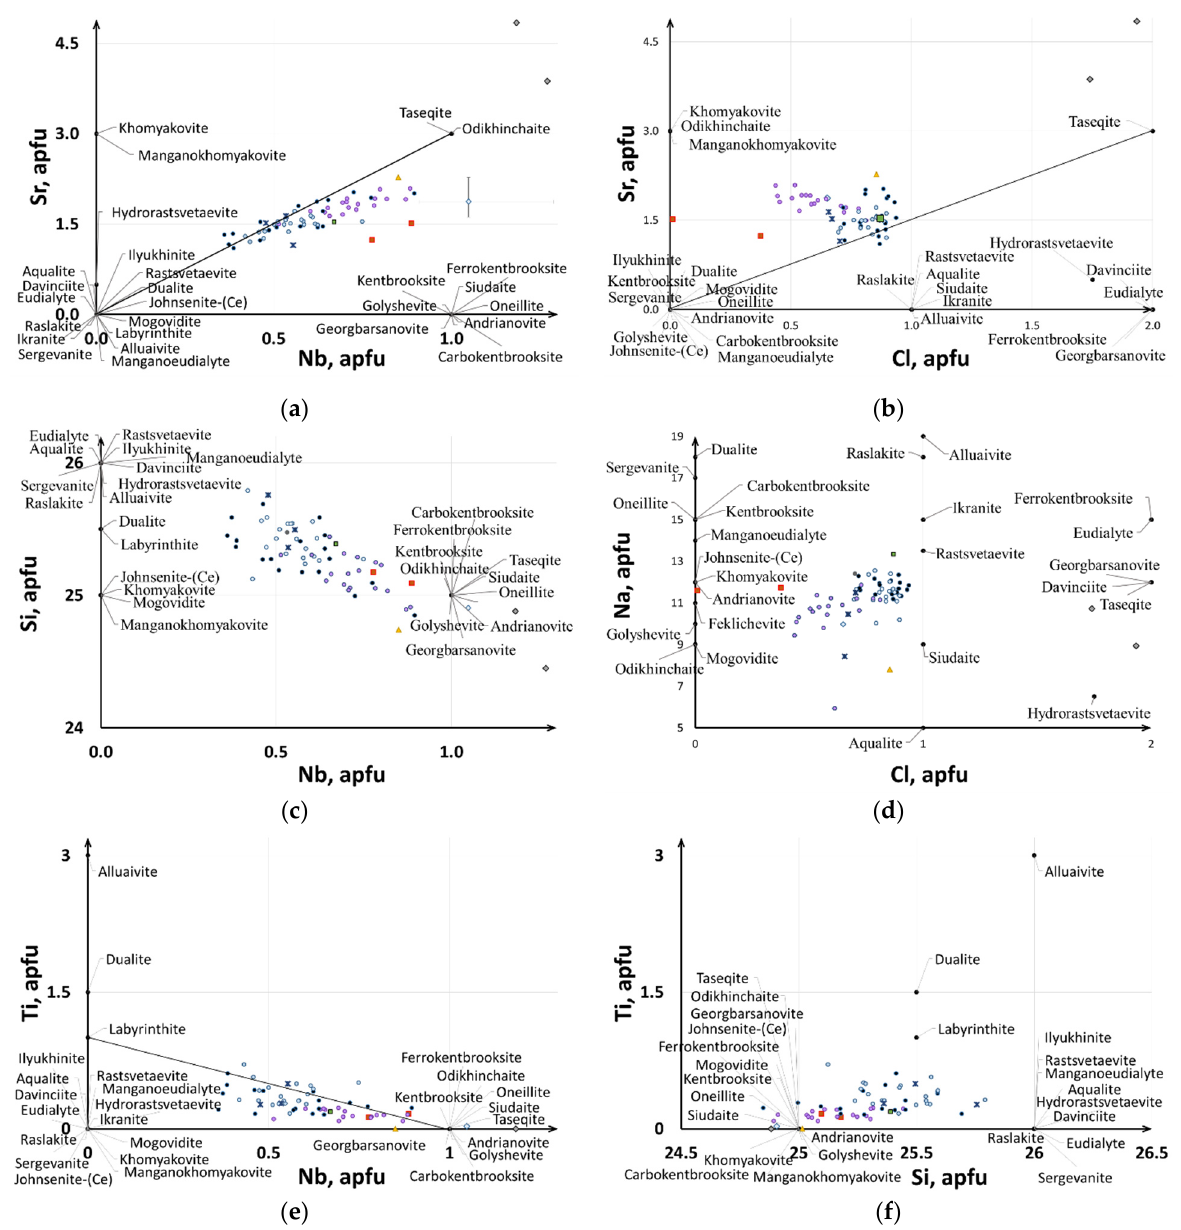
Figure 8. Chemical composition ( a – f ) of Nb-Sr-rich eudialyte-group minerals from the Odikhincha massif. New data: dark-blue dots—center and light-blue rime zone; violet dots—secondary zones of idiomorphic crystals; dark-blue crosses—xenomorphic crystals; light-blue diamond—odikhinchaite (Odikhincha); gray diamond—taseqite (Ilimaussak); green square—«Fe,Sr-analog of kentbrooksite (Lovozero)»; red square—«taseqite» (Khibina massif); and yellow triangle—«transitional to taseqite» (Pilansberg) [20,34–37].